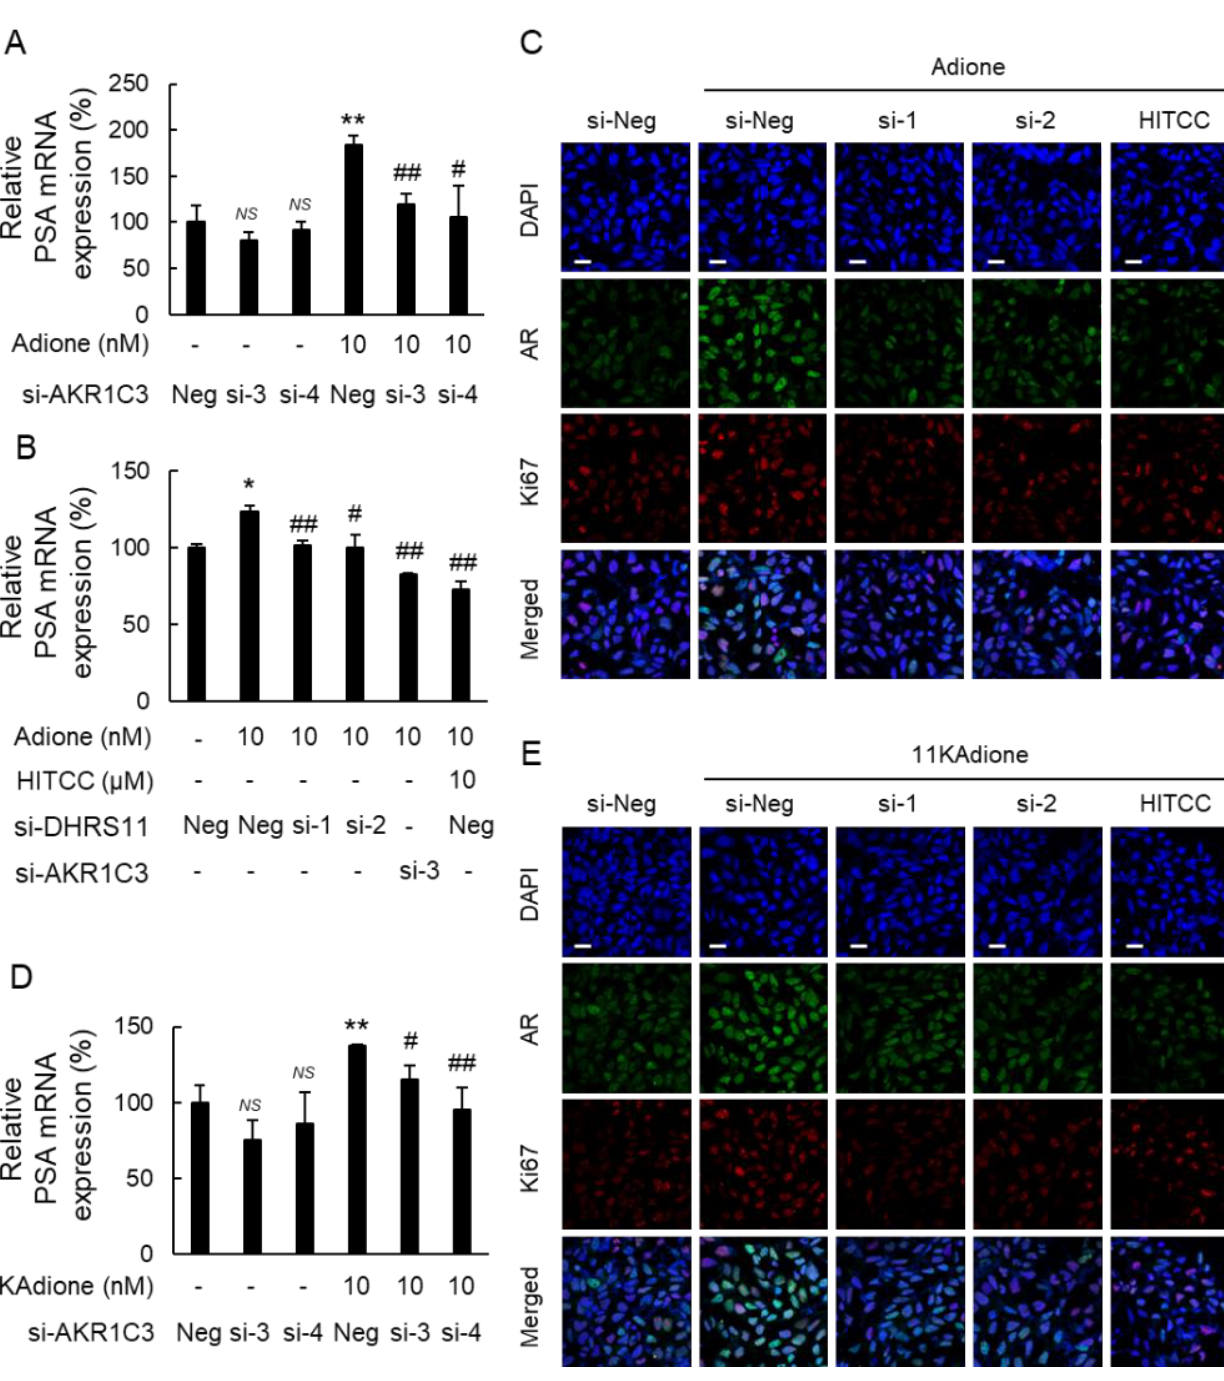
Figure 4. Effects of AKR1C3 knockdown on androgen signaling induced by Adione or 11KAdione